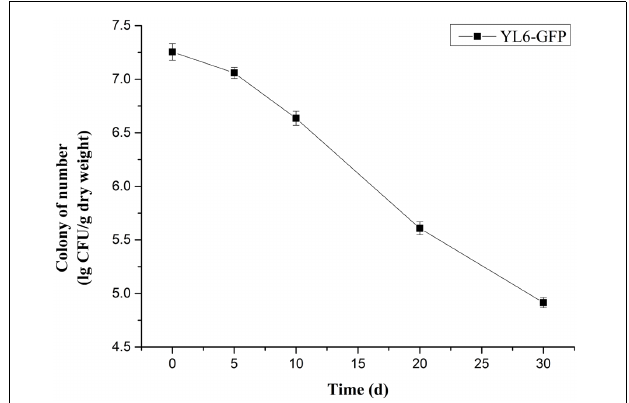
FIGURE 2 | Colonization byYL6-GFP in the rhizosphere soil of Chinese